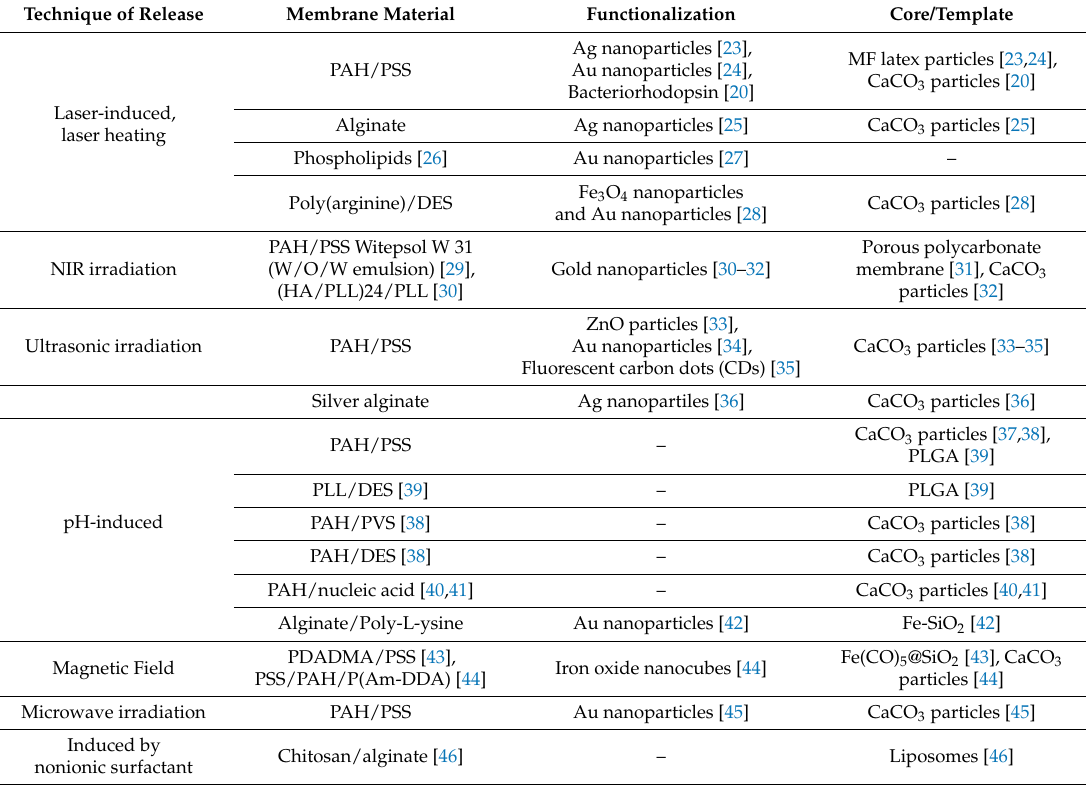
Table 1. Summary of different mechanisms used for controlling the permeability between different types of membranes. Further, abbreviations of polymers used as membrane materials: PAH, poly(allylamine hydrochloride); PSS, poly(4-styrenesulfonic acid) sodium salt); MF, melamineformaldehyde; HA, hyaluronic acid; PLL, poly(l-lysine); DES, dextran sulfate; PVS, poly(vinyl sulfate); PLGA, poly(lactic-co-lycolic acid); PDADMA, poly(diallyldimethylammonium chloride); P(Am-DDA), poly(acrylamide-co-diallyl-dimethylammonium